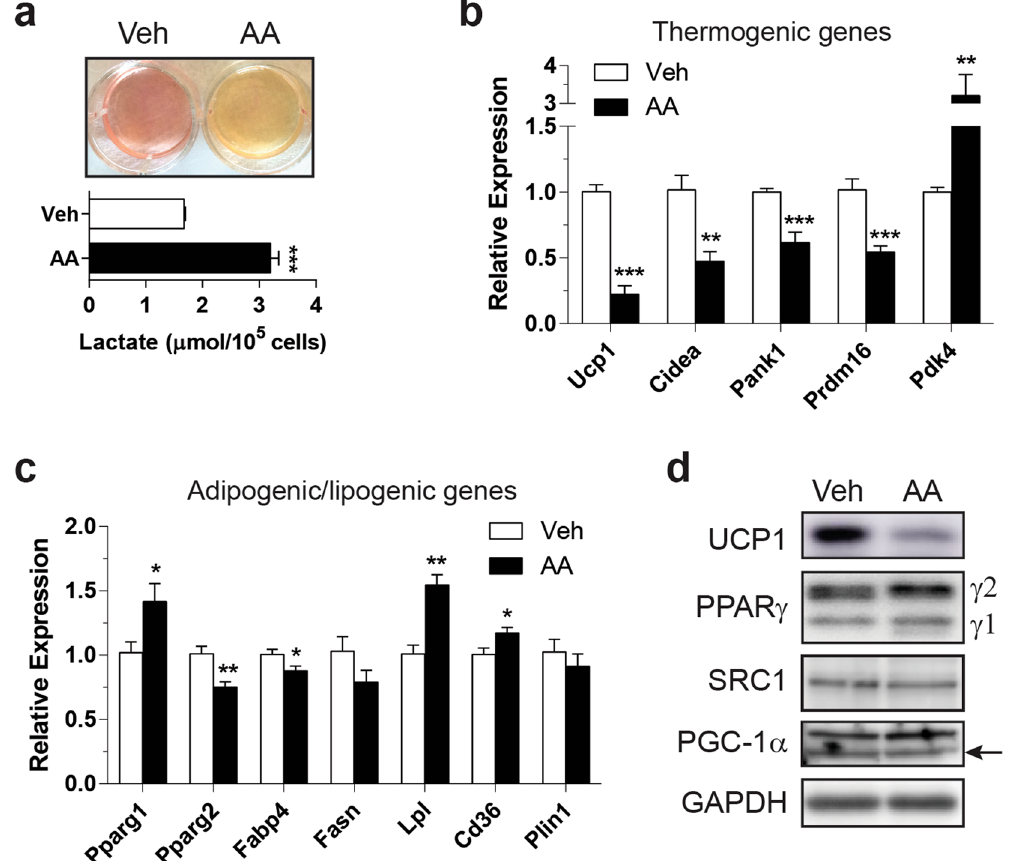
Figure 4. Pharmacological inhibition of respiratory complex mimics LRPPRC ablation in cultured brown adipocytes. ( a ) Representative image of acidic media (upper) and lactate production (lower) in primary brown adipoytes treated with 10 nM AA for 18 hr. ( b , c ) mRNA levels of thermogenic genes ( b ) and adipogenic/ lipogenic genes ( c ). ( d ) Immunoblot of UCP1, PPAR γ , SRC-1, PGC-1 α and GAPDH (loading control). Data are mean ± SEM. * P < 0.05, ** P < 0.01, *** P < 0.001, two-tailed unpaired Student’s t -test ( a – c